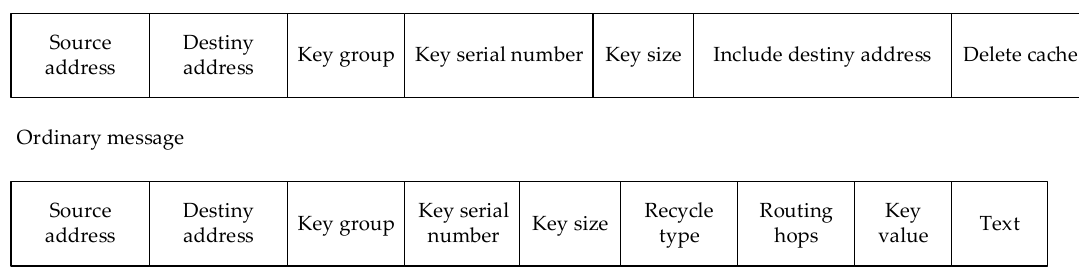
Figure 6. QKP communication message format ： broadcast message format and ordinary message Figure6. QKPcommunicationmessageformat: broadcastmessageformatandordinarymessageformat. format.